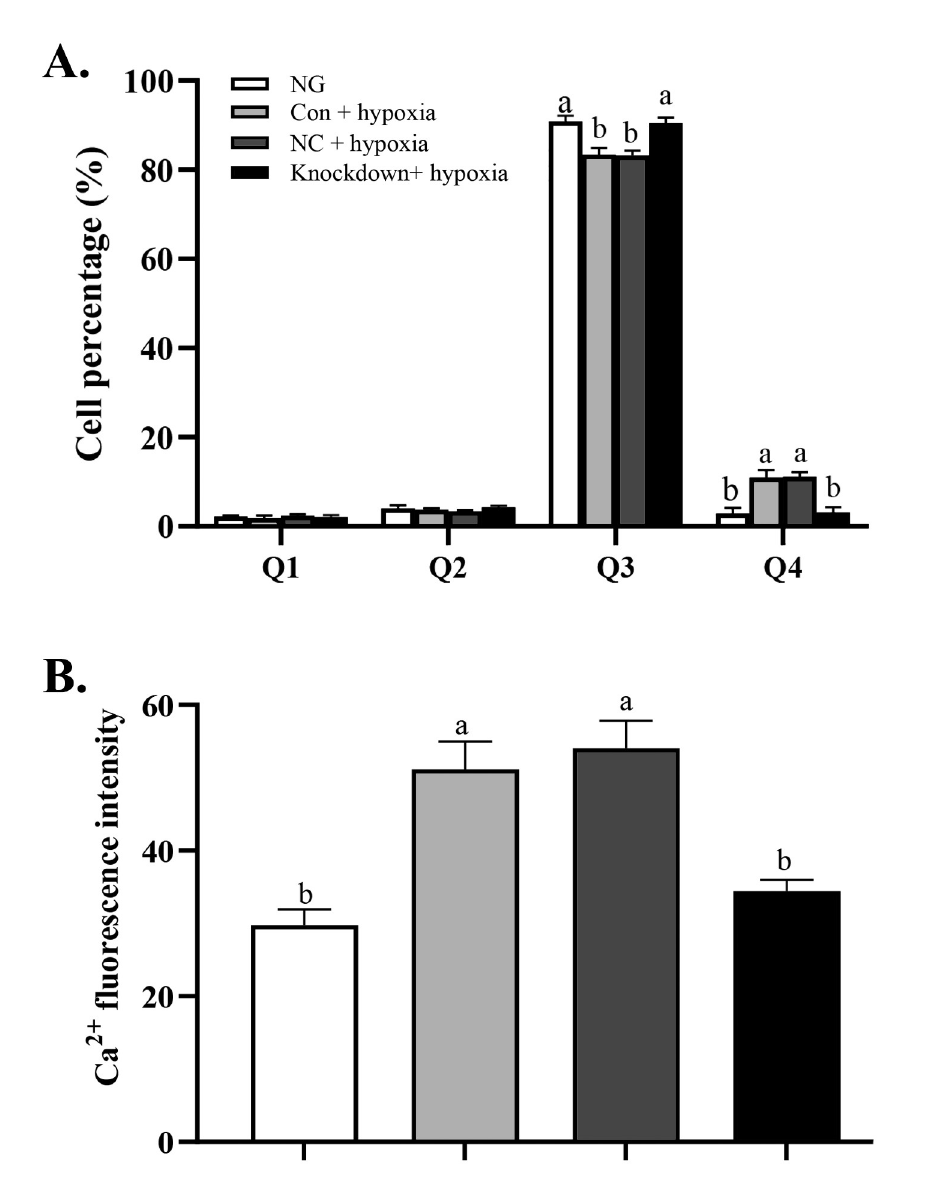
Fig 4. Effect of CaSR knockdown on apoptosis and Ca 2+ concentration in hepatocytes of GIFT under hypoxia stress. (A) Proportion of apoptotic cells in NG, knockdown+ hypoxia, NC+ hypoxia and Con+ hypoxia groups. Figure shows percentages of dead cells (Q1), late apoptotic cells (Q2), viable cells (Q3), and early apoptotic cells (Q4). (B) Ca 2+ fluorescence intensity in NG, knockdown+ hypoxia, NC + hypoxia, and Con + hypoxia groups. Different lowercase letters indicate significant differences among experimental groups (Duncan’s multiple range test, P <